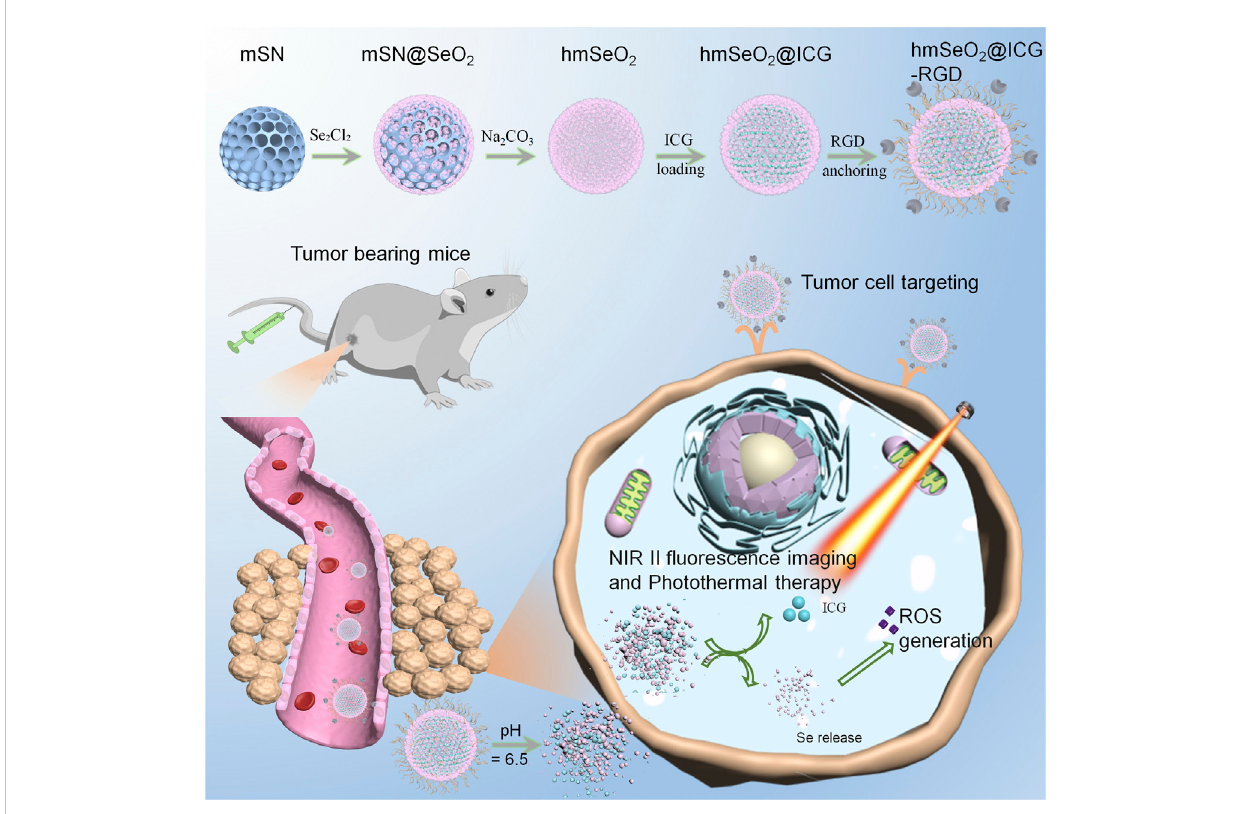
FIGURE 1 Schematicillustration ofstep-wise hmSeO 2 @ICG-RGD synthesis for NIR II fl uorescence imaging and synergistictumor eradiation via photothermal therapy and ROS mediated oxidative therapy.